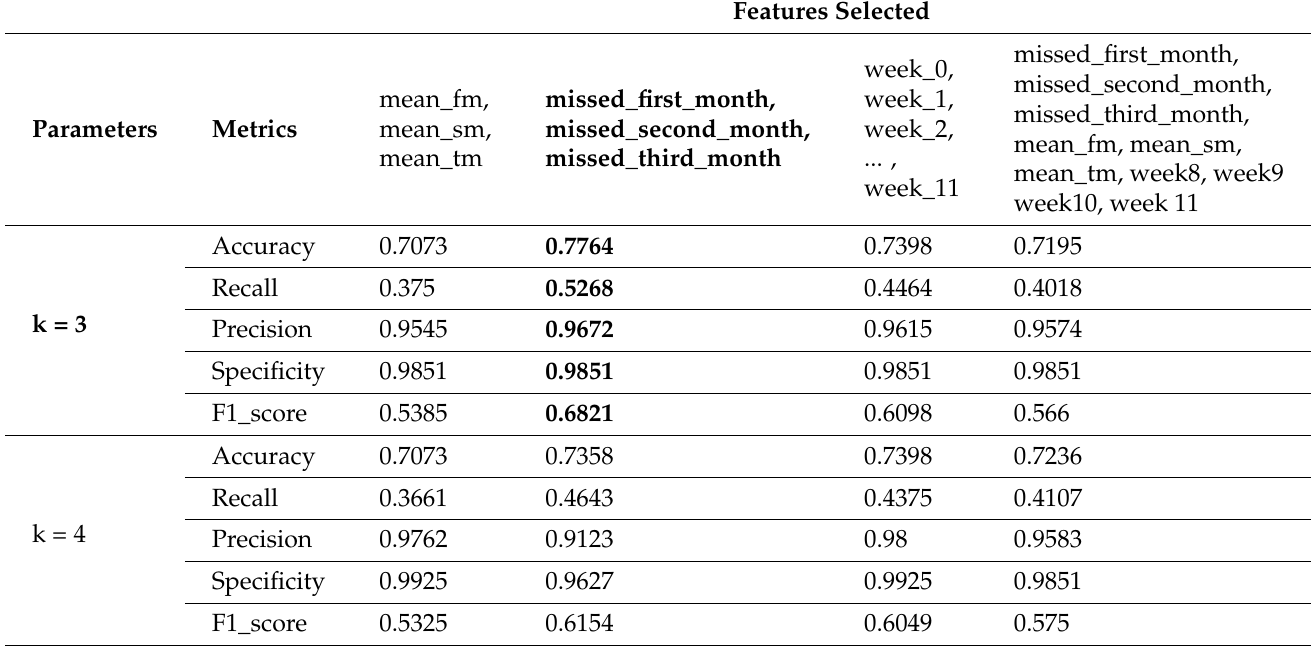
Table 14. Metrics, applying different configurations for k-means clustering—SVR. Features